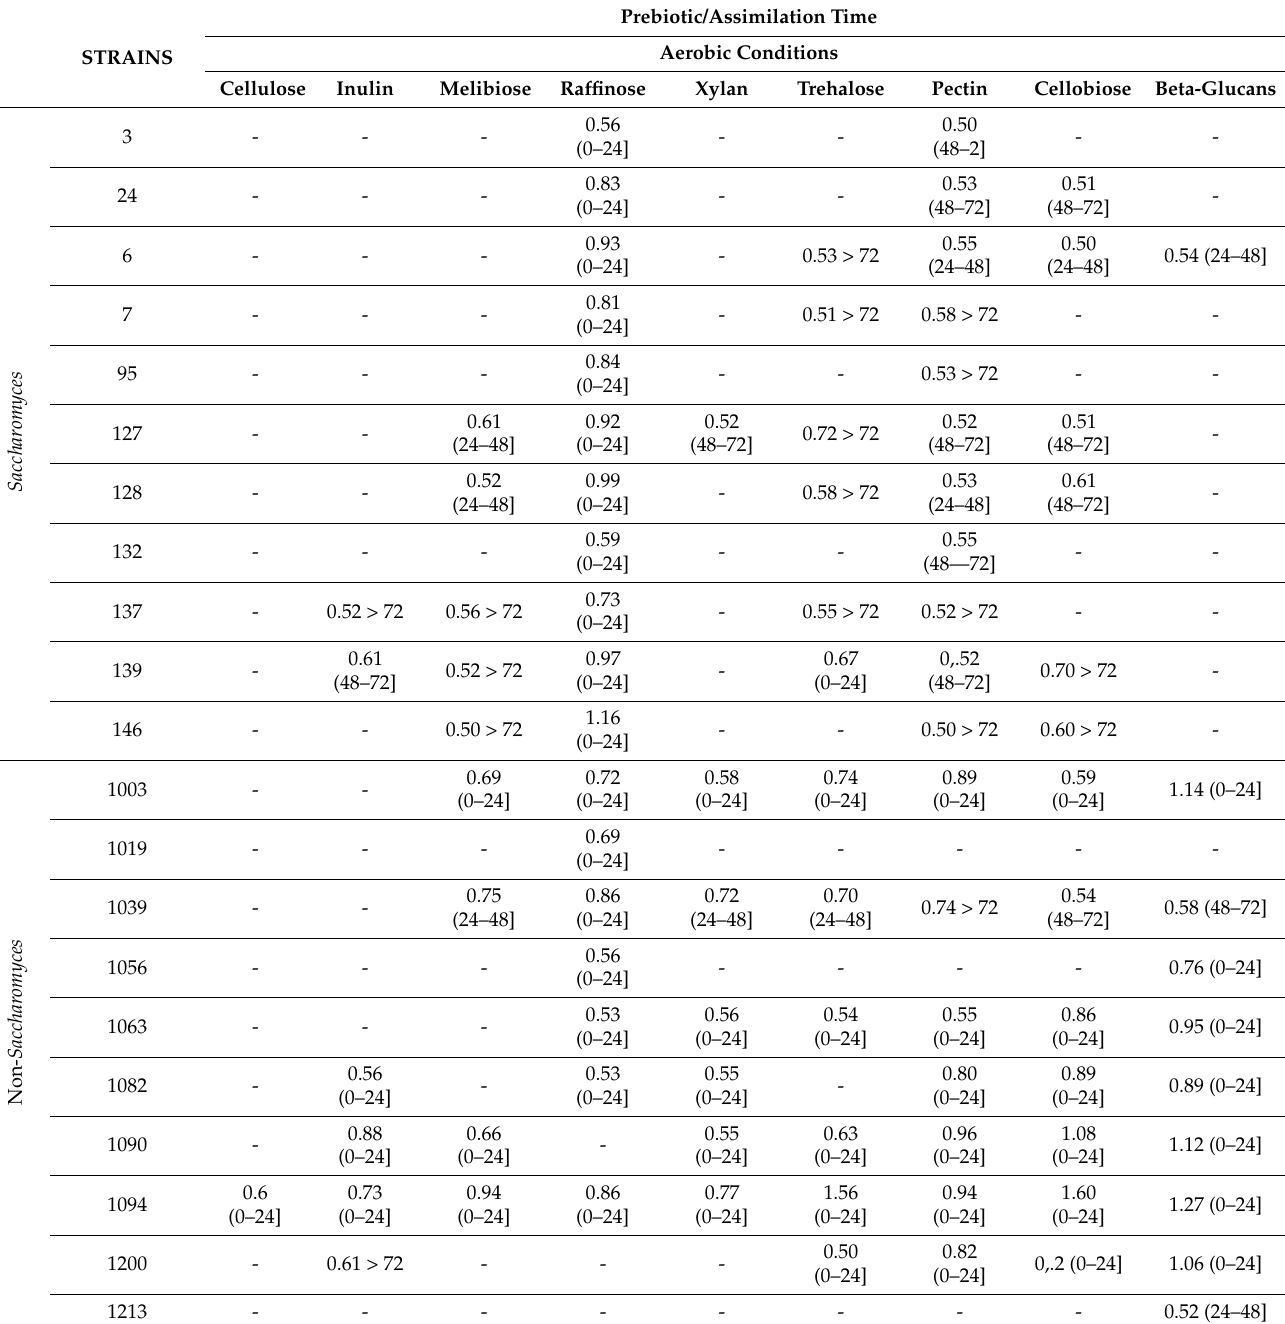
Table 2. Prebiotic metabolisms under aerobic and anaerobic conditions. Increase in absorbance at 600 nm between 0 and >72 h.